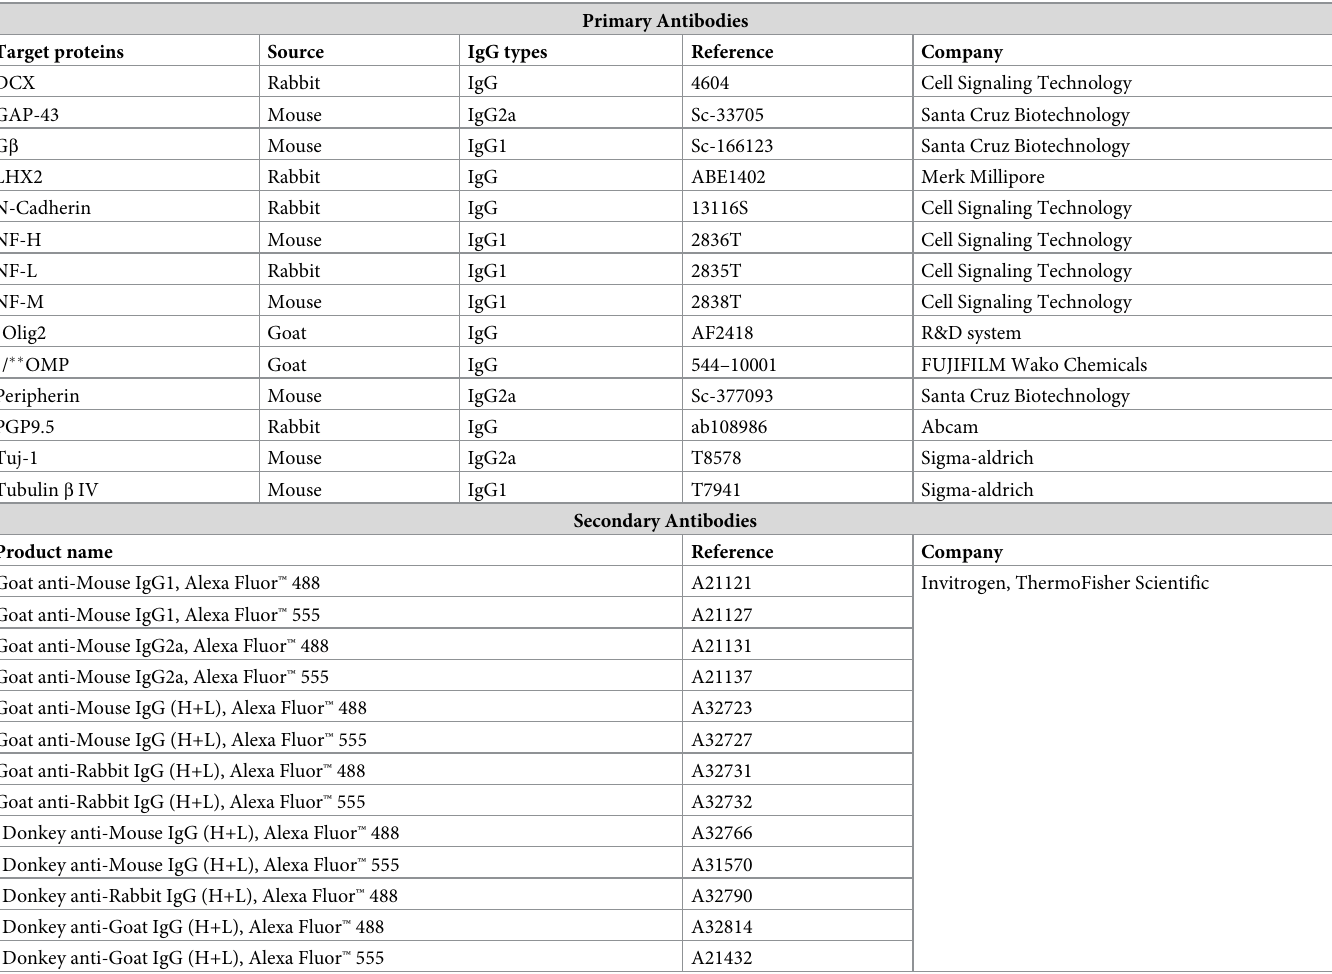
Table 1. List of validated primary and secondary